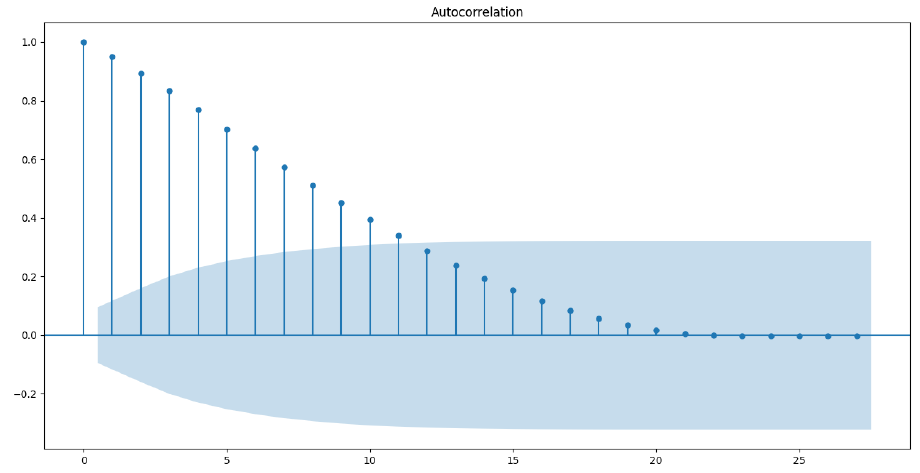
Figure 7. ACF (Autocorrelation